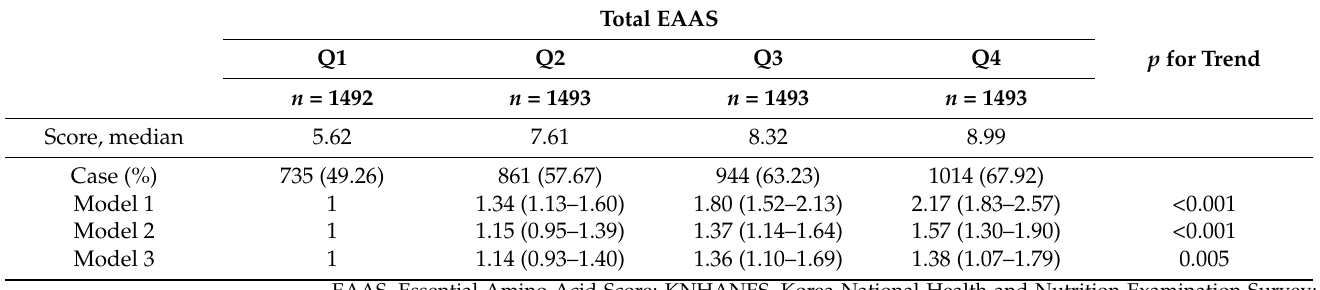
Table 2. Multivariable logistic regression analysis between total EAAS and high muscle strength,